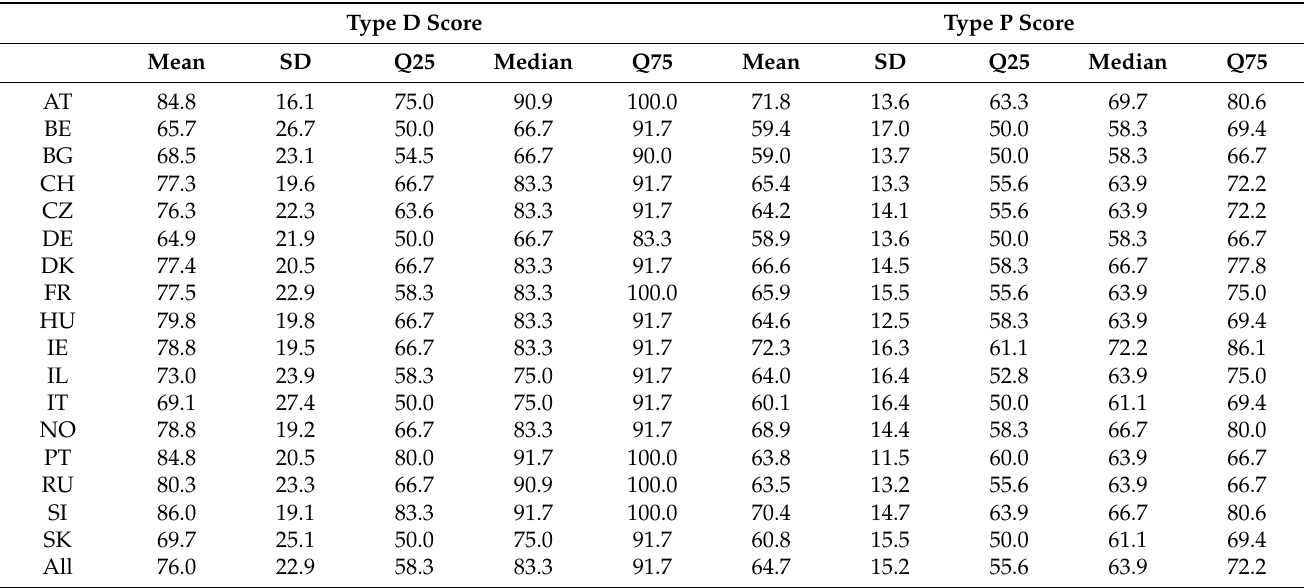
Table 11. Descriptive statistics of type D and type P score, for each country and for all countries (equally weighted).